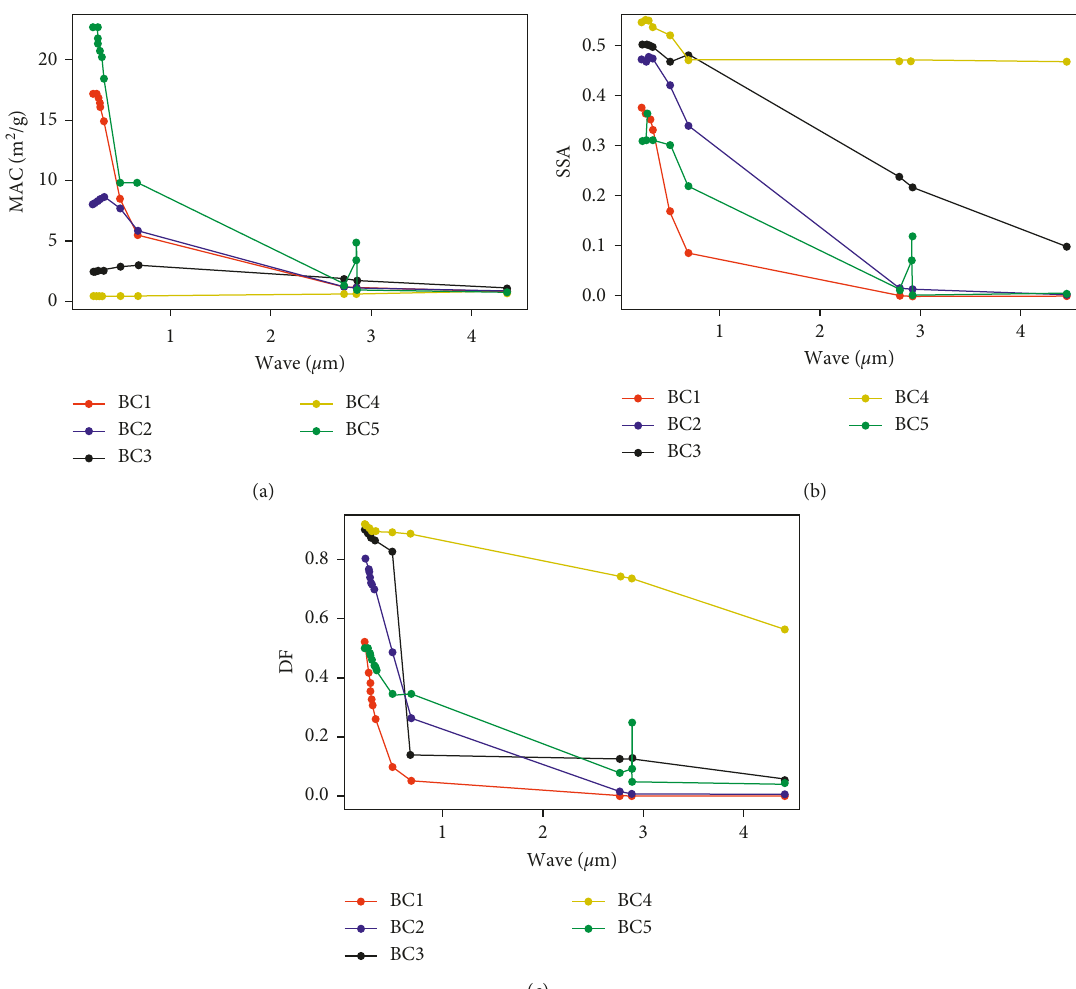
Figure 2: Variations of the optical properties of BC aerosols of different bins with the